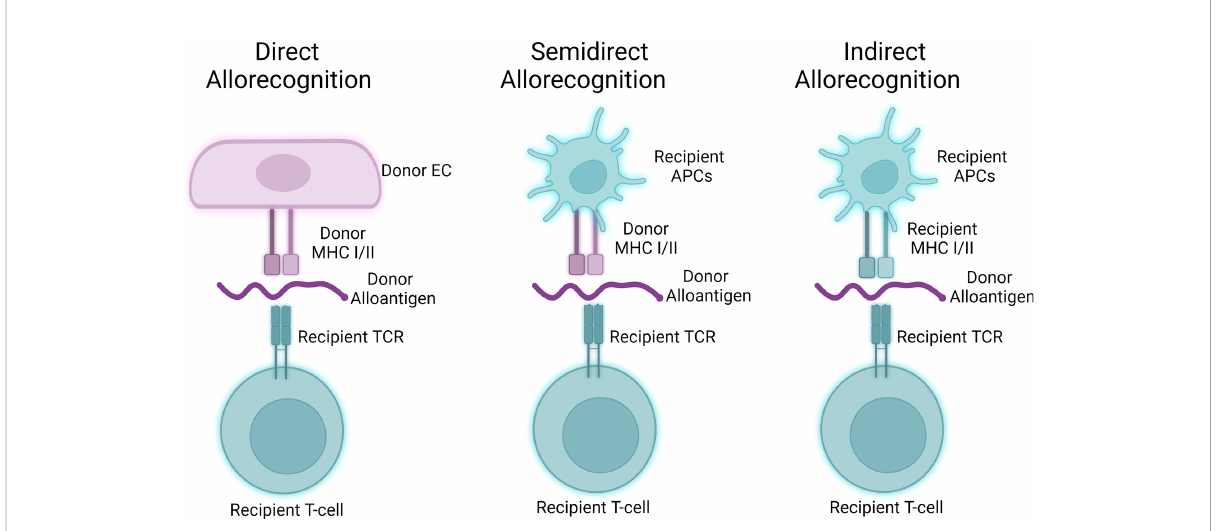
FIGURE 2 Three pathways of allorecognition. Donor-derived alloantigens may activate allogeneic T cells via three separable pathways. Human endothelial cells may act as antigen presenting cells to participate in direct allorecognition responses (left), while murine hosts primarily participate in semidirect and indirect allorecognition (middle, right) through interactions involving professional antigen presenting